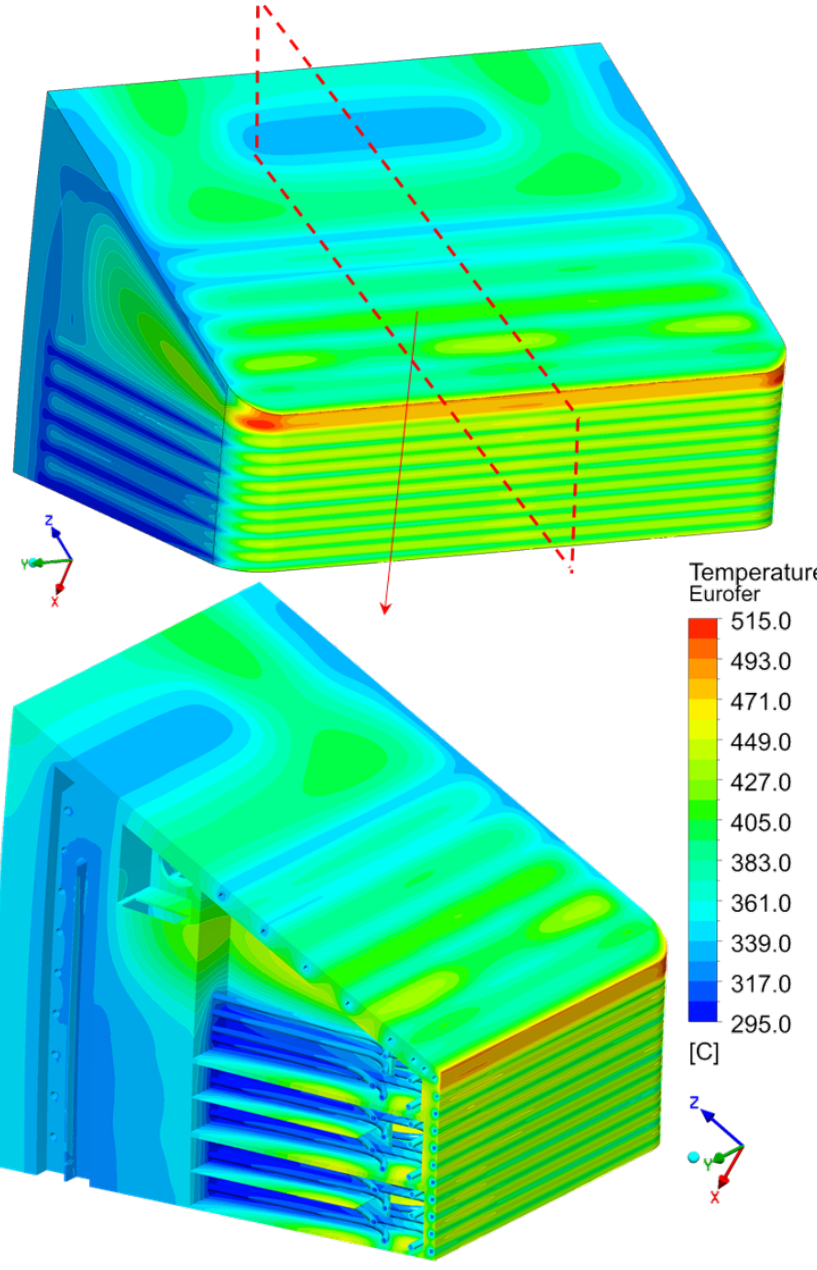
Figure 16. Thermal field of the Eurofer